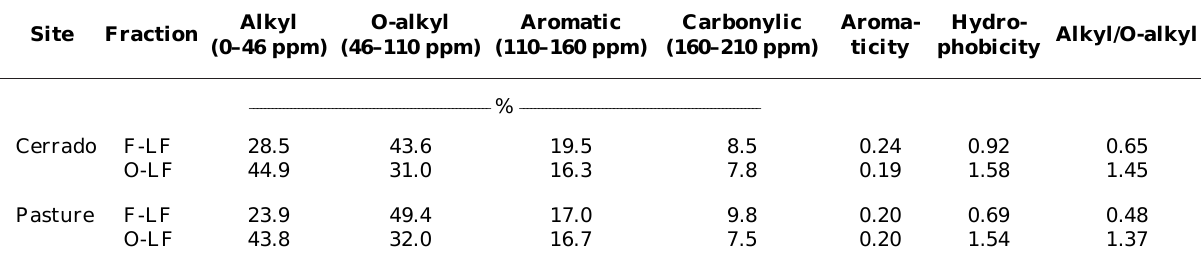
Table 3. Proportions of the different groups (%) present in the 13 C-CPMAS-NMR spectra, calculated after VCT experiments (Conte et al., 1997), and the derived indices aromaticity , hydrophobicity , and alkyl/ O-alkyl ratio, in the different density fractions: free light fraction (F-LF), occluded light fraction (O-LF), and heavy fraction (HF)